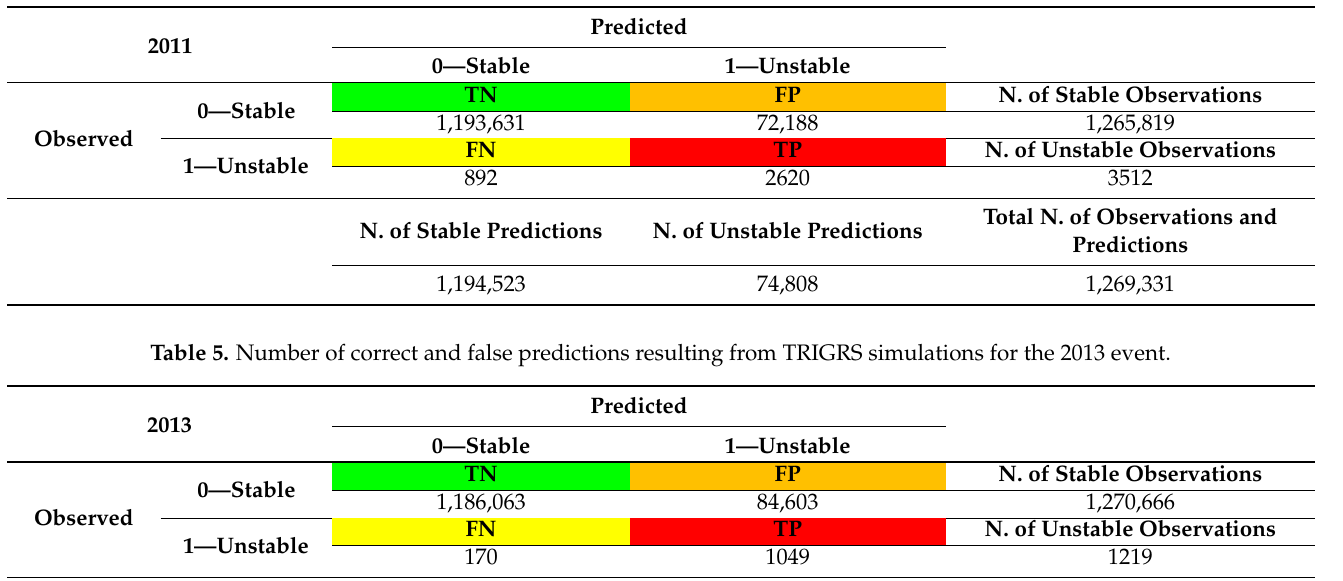
Table 4. Number of correct and false predictions resulting from TRIGRS simulations for the 2011 event.